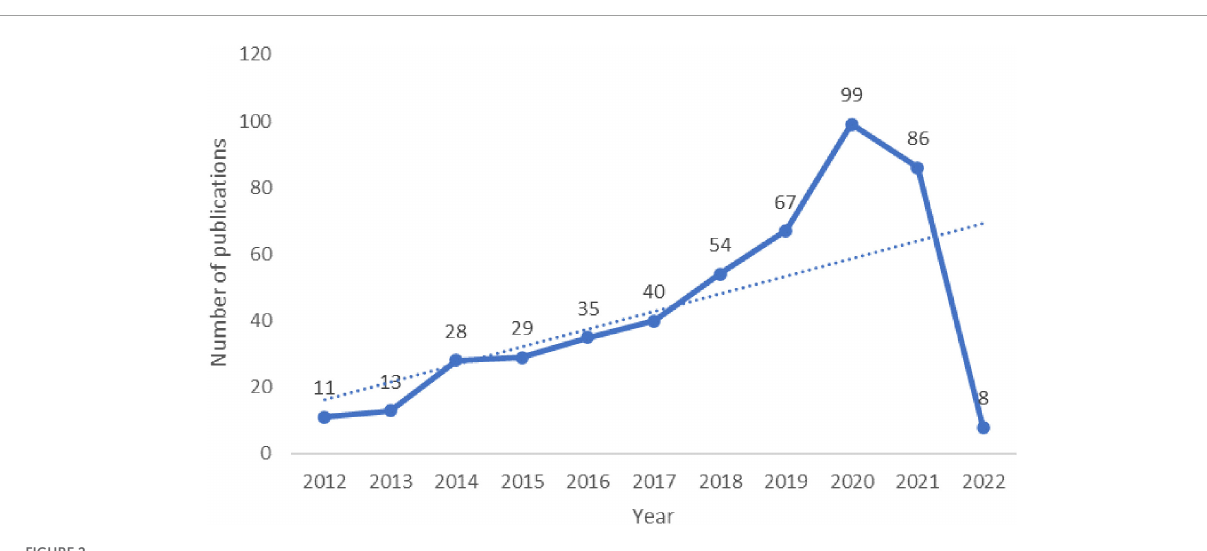
for disease research gradually increased and reached the highest value in 2019. Although the included literature from 2022 did not represent the complete year, the overall trend was still upward ( Figure 2 ), and since 2018, the total number of articles published each year has exceeded